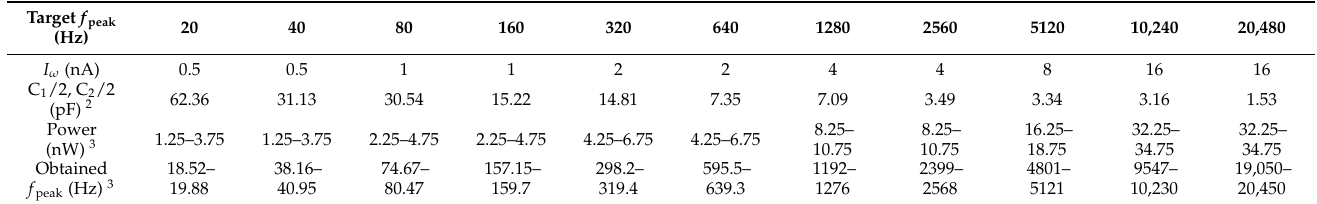
Table 1. Simulated 1 post-layout parameters of the individual filters with V DD = 0.5 V.